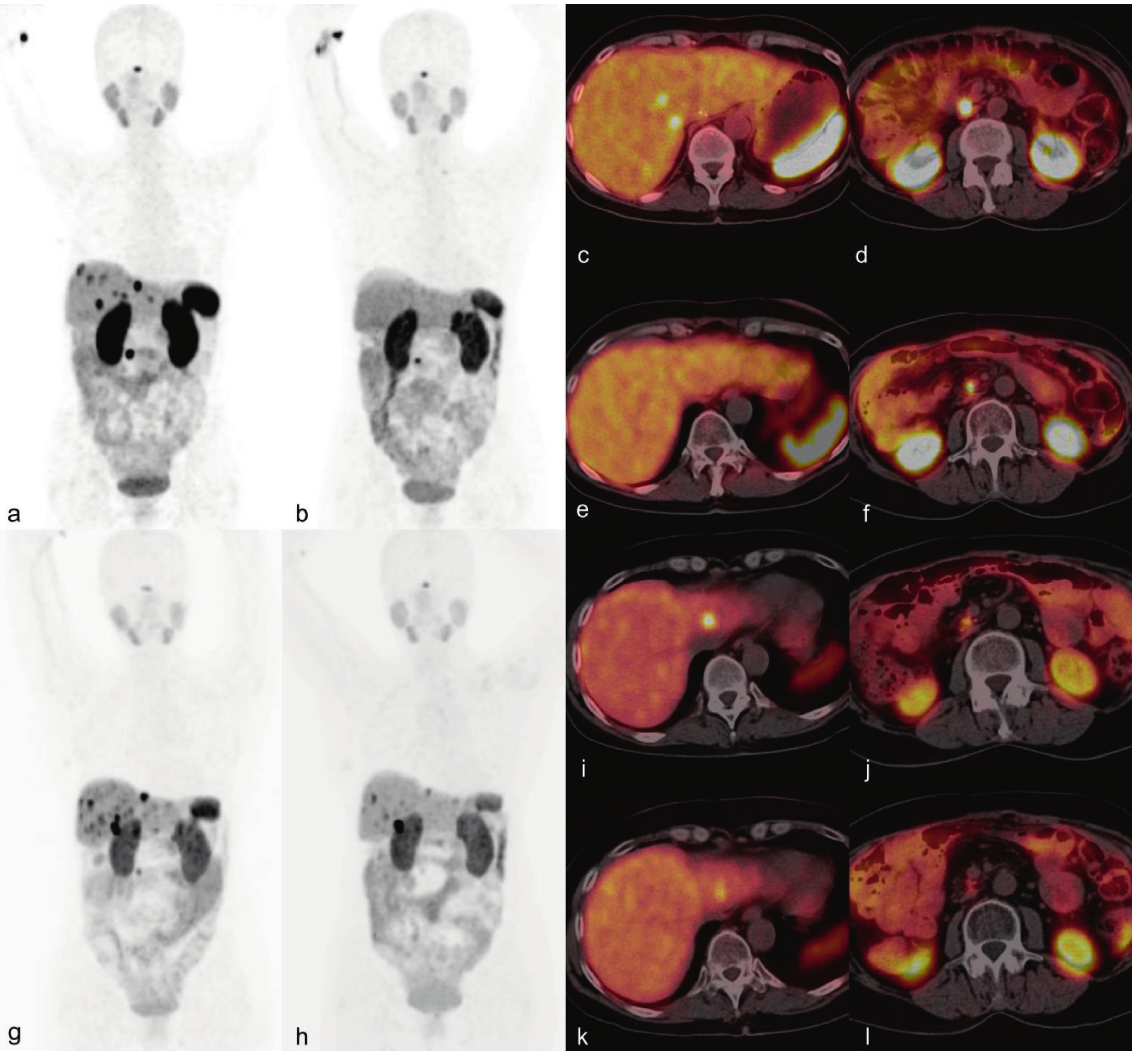
Figure 4: Example of the effect of the repeated tandem [ 90 Y]Y/[ 177 Lu]Lu-DOTATATE therapy: a 51-year-old woman with a nonfunctional pancreatic G2 NETafter surgery for primary tumours, with progression of the disease after 4 months. The [ 68 Ga]Ga-DOTATATE PET/CT carried out for qualification to the PRRT showed increased uptake (higher than in the liver) in multiple metastases in the liver and lymph node. The patient received the initial PRRTand the repeated PRRT with the total accumulated injection activity of 20.7GBq. The PFS rate after the I-PRRTand the R-PRRTwas 24 and 21 months, respectively. The disease progression after each therapy course was observed in the same parts of the body. (a) [ 68 Ga]Ga-DOTATATE PET MIP before the I-PRRTshowing increased uptake in multiple metastases; (b) [ 68 Ga] Ga-DOTATATE PET MIP after the I-PRRTwith complete response in the liver metastases and partial response in the lymph node; and axial fusion [ 68 Ga]Ga-DOTATATE PET/CT (c, d) before and (e, f) after the I-PRRT. (g) [ 68 Ga]Ga-DOTATATE PET MIP before the R-PRRT showing progression of the disease after the I-PRRT; (h) [ 68 Ga]Ga-DOTATATE PET MIP after the R-PRRTwith partial response; and axial fusion [ 68 Ga]Ga-DOTATATE PET/CT (i, j) before and (k, l) after the